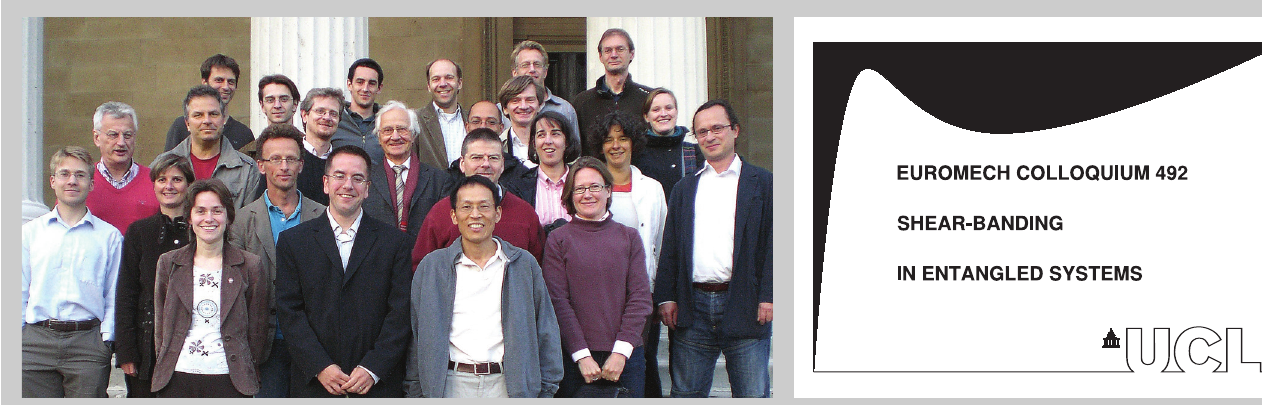
Figure 1 (left): Group photo from Euromech Colloquium 492 at UCL. Figure 2: Conference logo of Euromech colloquium